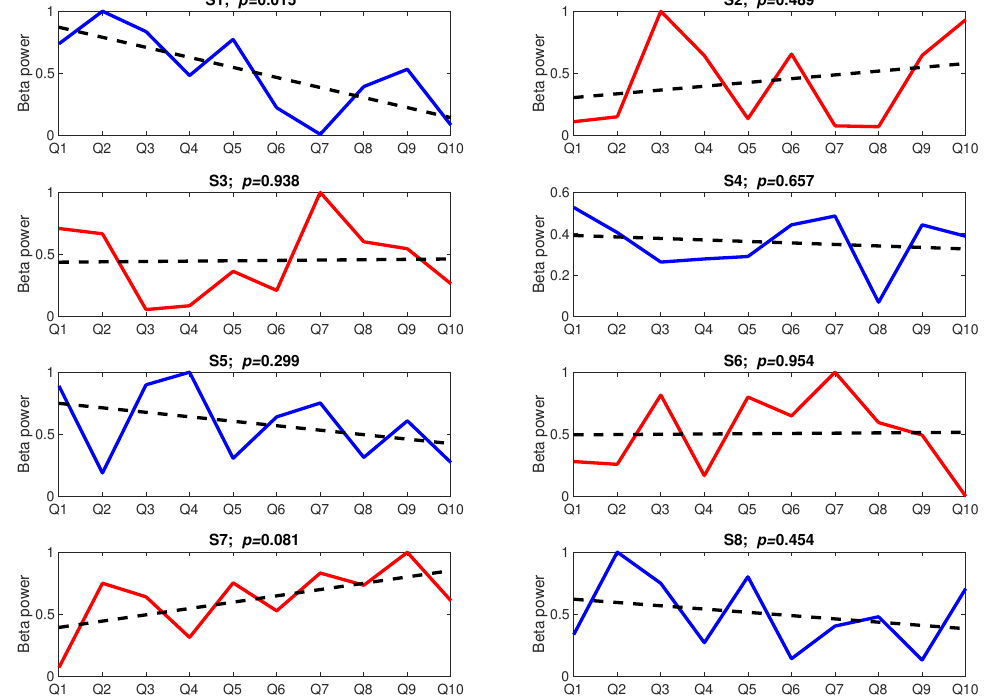
Figure 10. The stress-inducing events from Task A over time; upward trends are marked in red, downward trends are marked in blue, dotted lines present linear trends, asterisks (*) denote linear trends with a significant slope ( p -value < 0.05); Q: Question, S: Subject.